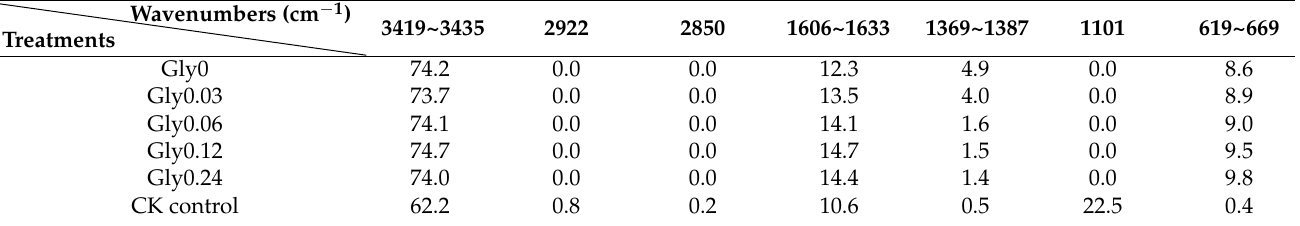
Table 1. FTIR relative intensities (% of total area) for the dark-brown residue under different glycine concentrations in the Maillard